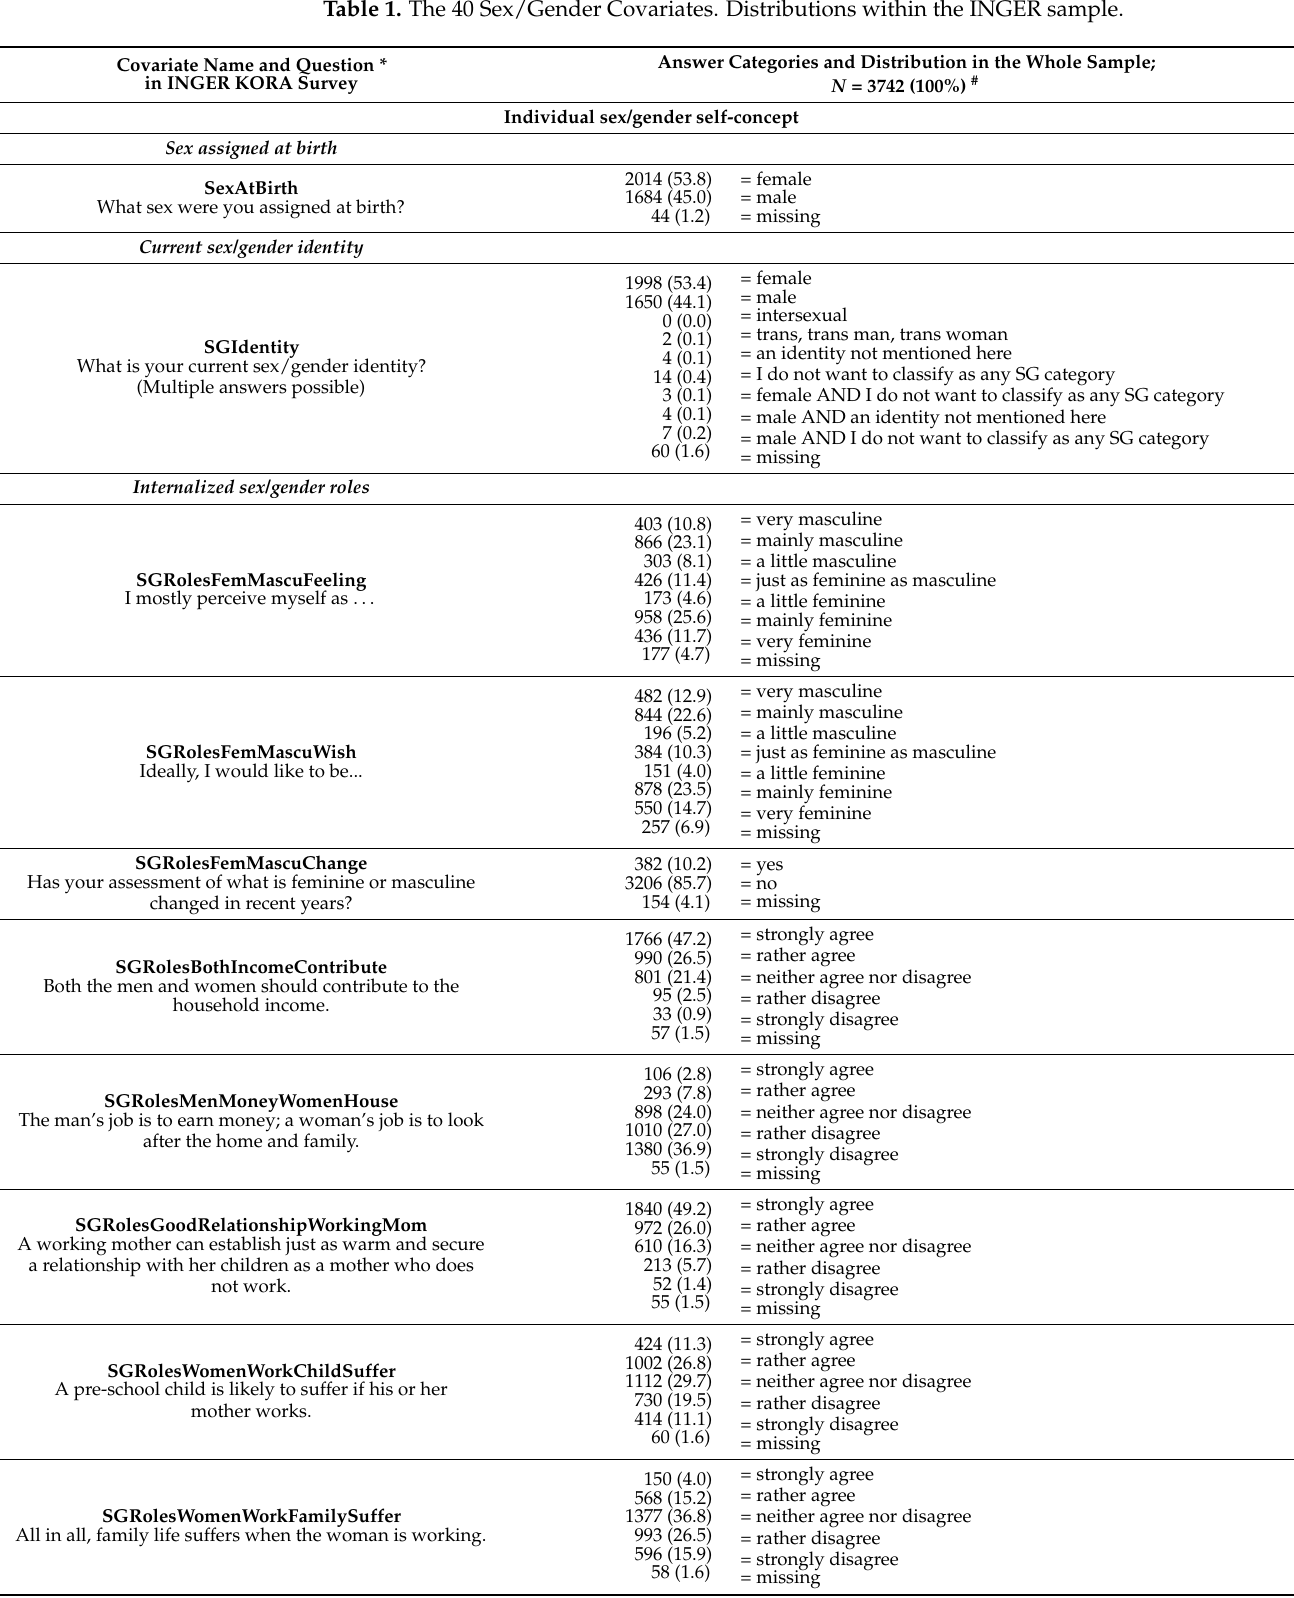
Table 1. The 40 Sex/Gender Covariates. Distributions within the INGER